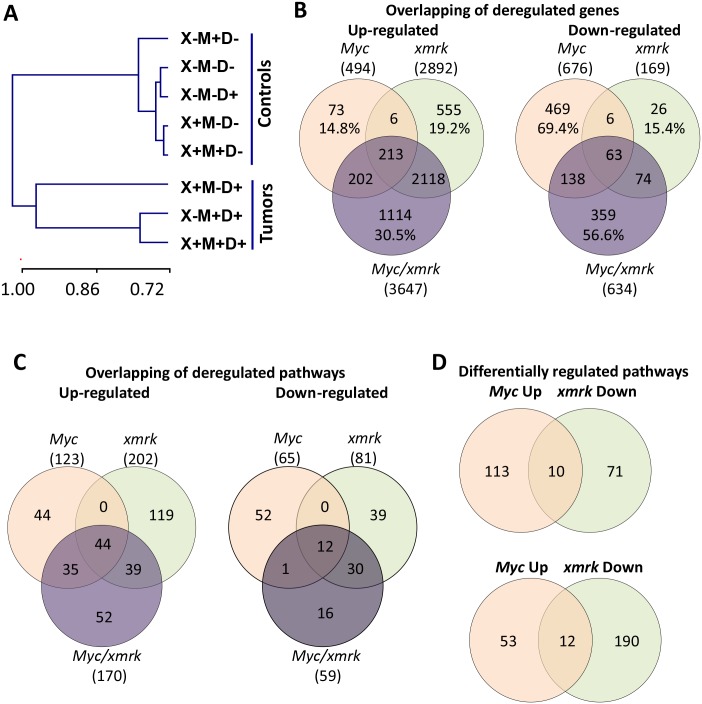
RNA-Seq analyses of Myc-, xmrk-, Myc/xmrk-induced liver tumors.(A) Hierarchical clustering of the eight RNA-Seq samples.(B) Venn diagram of up- and down-regulated transcripts in the three liver tumors. (C) Venn diagram of up-and down-regulated canonical pathways in the three liver tumors. (D) Venn diagram of pathways with opposite directions between Myc- and xmrk-induced liver tumors.